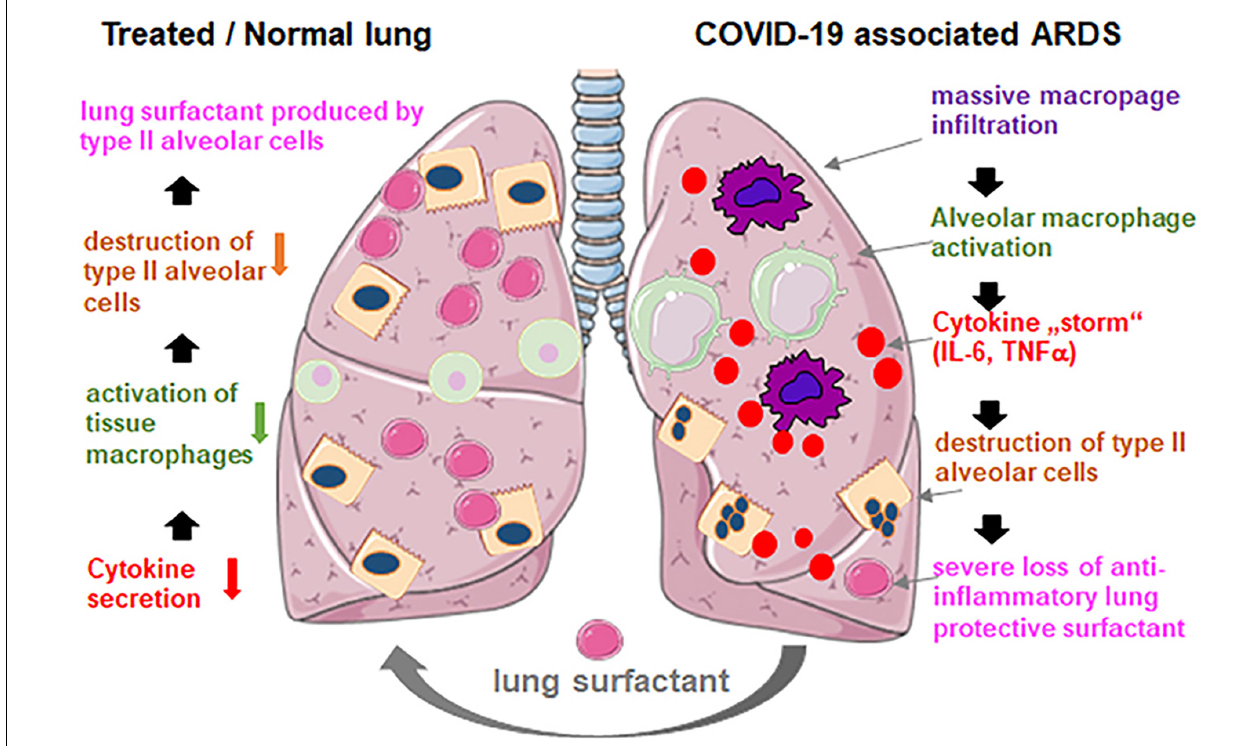
FIGURE 12 | Exogenous lung surfactant delivery suggested as a therapy to reduce inflammation and restore pulmonary barrier in severe COVID-19 associated acute respiratory distress syndrome (ARDS). Reprinted from Mirastschijski et al. (2020) with